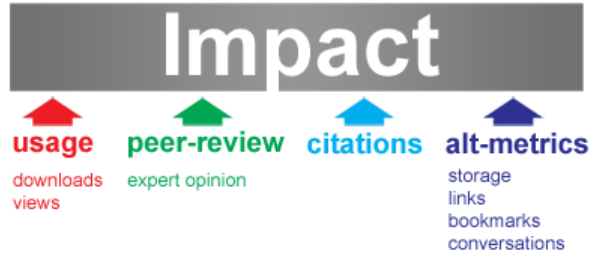
Figure 2. Four ways to measure